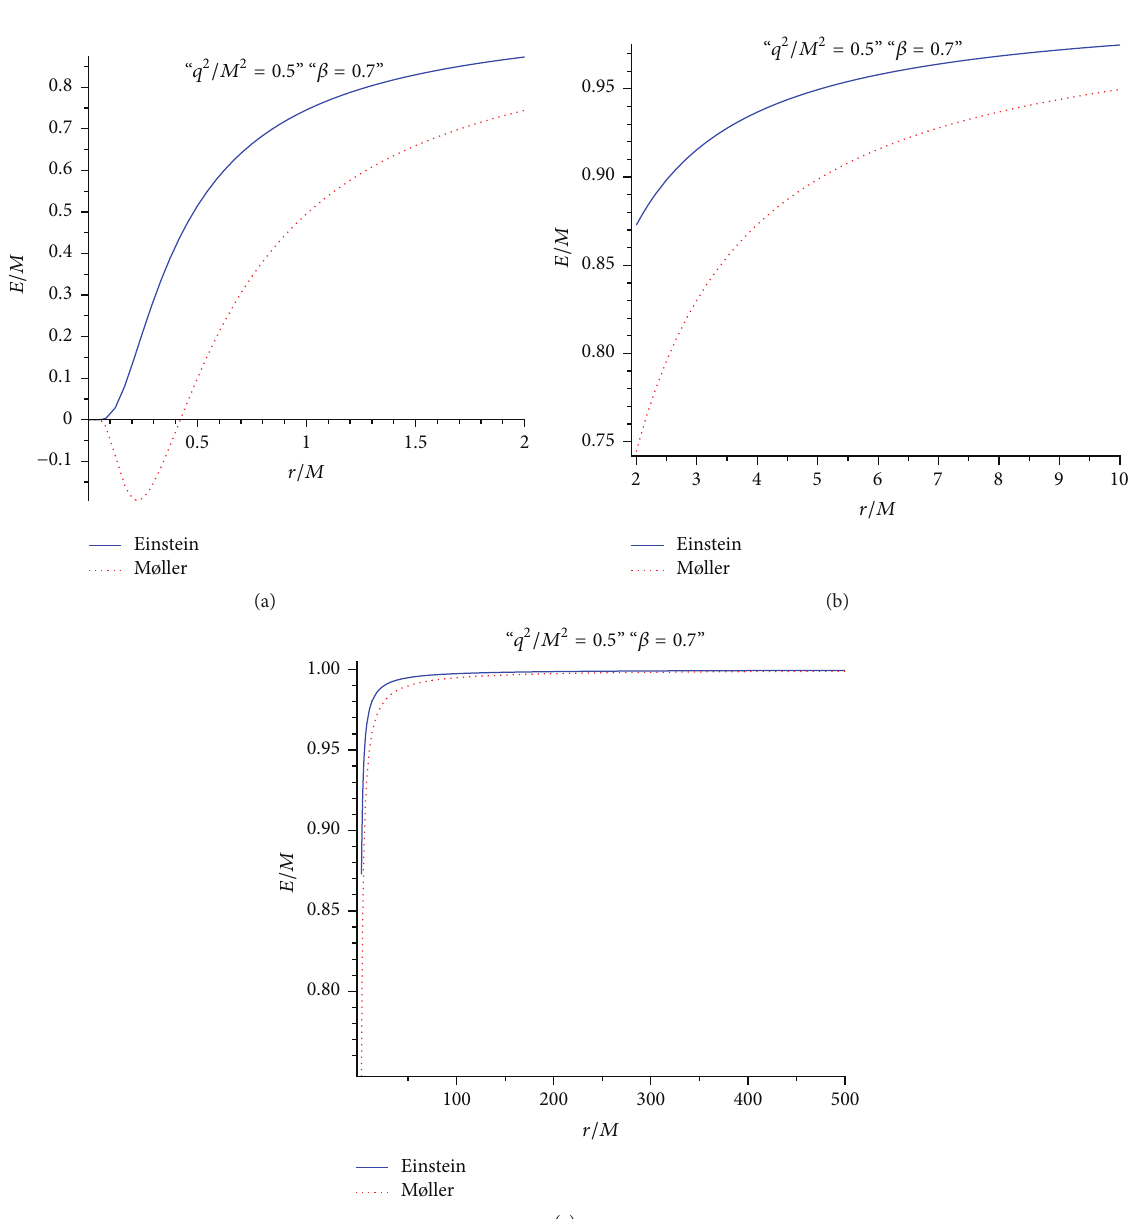
Figure 4: For the fixed value of 𝛽 = 0.7 and (𝑞/𝑀) 2 = 0.5 : (a) Comparison of Einstein and Møller energies near the origin. (b) Comparison of the energy distribution performed by the Einstein and Møller prescriptions outside the outer horizon. (c) Comparison of the energy distribution performed by the Einstein and Møller prescriptions for very large values of 𝑟